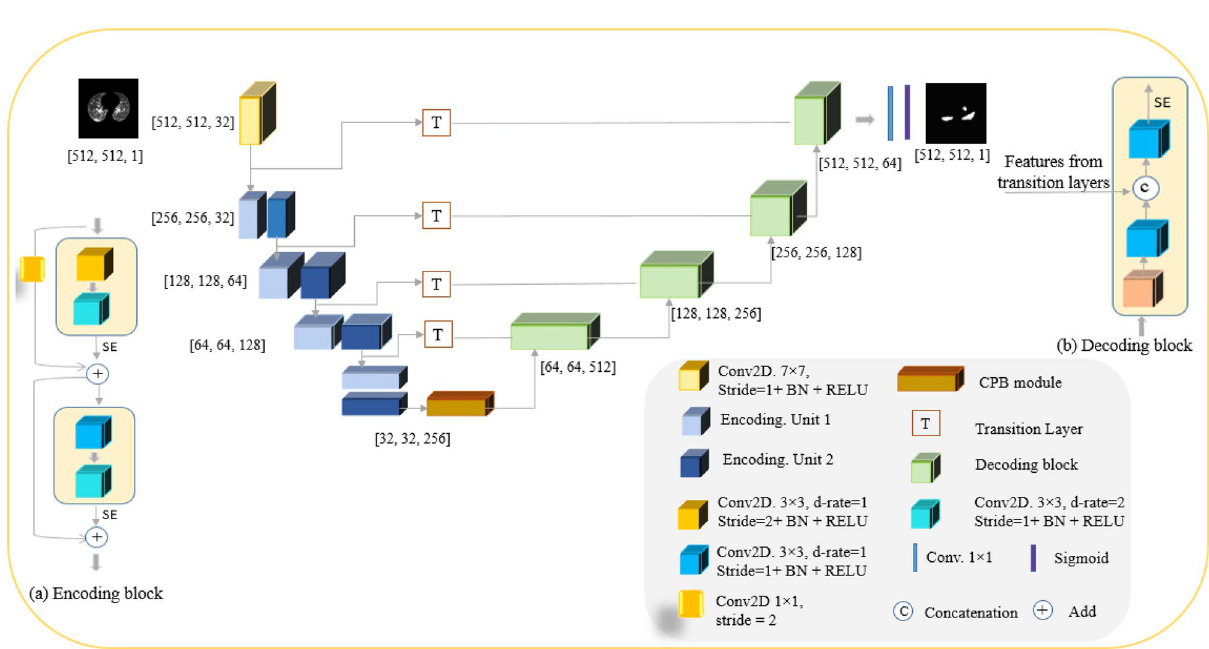
Figure 7. Architecture of the proposed COVID-Rate segmentation